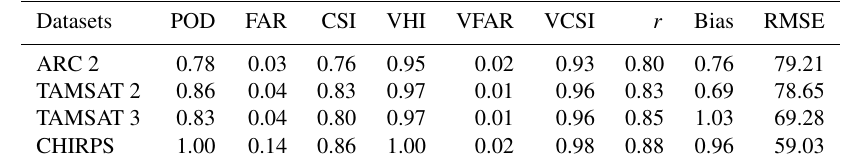
Table 3. Summary of the point-to-grid evaluation at a monthly temporal scale using categorical, volumetric, and continuous statistical tools. Probability of detection (POD), false alarm ratio (FAR), critical success index (CSI), volumetric hit index (VHI), volumetric false alarm ratio (VFAR), volumetric critical success index (VCSI), correlation coefficient ( r ), bias, and the root mean square error (RMSE). The RMSE values are shown in millimeters.